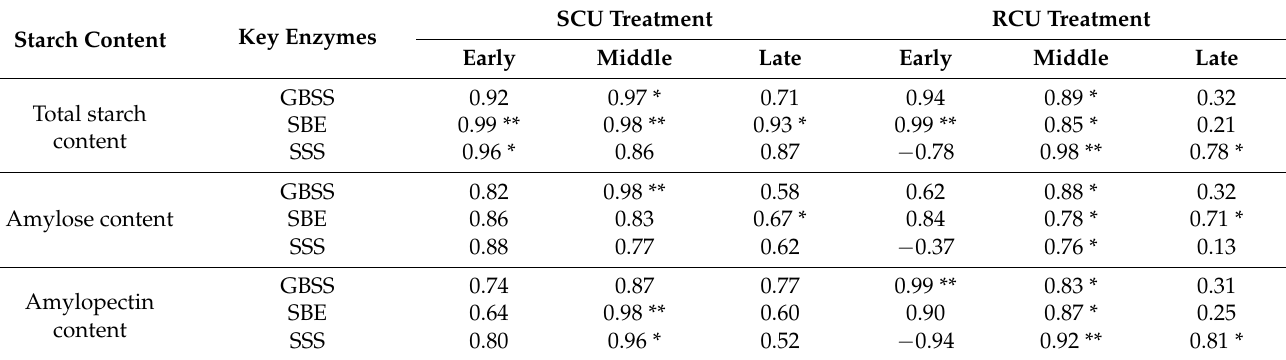
Table 4. Correlation analysis of key enzyme activities for starch synthesis and starch